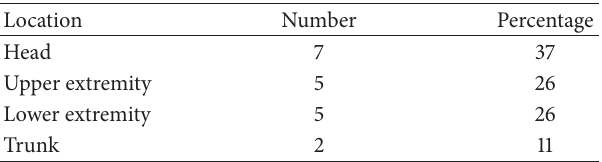
Table 2: Patterns of